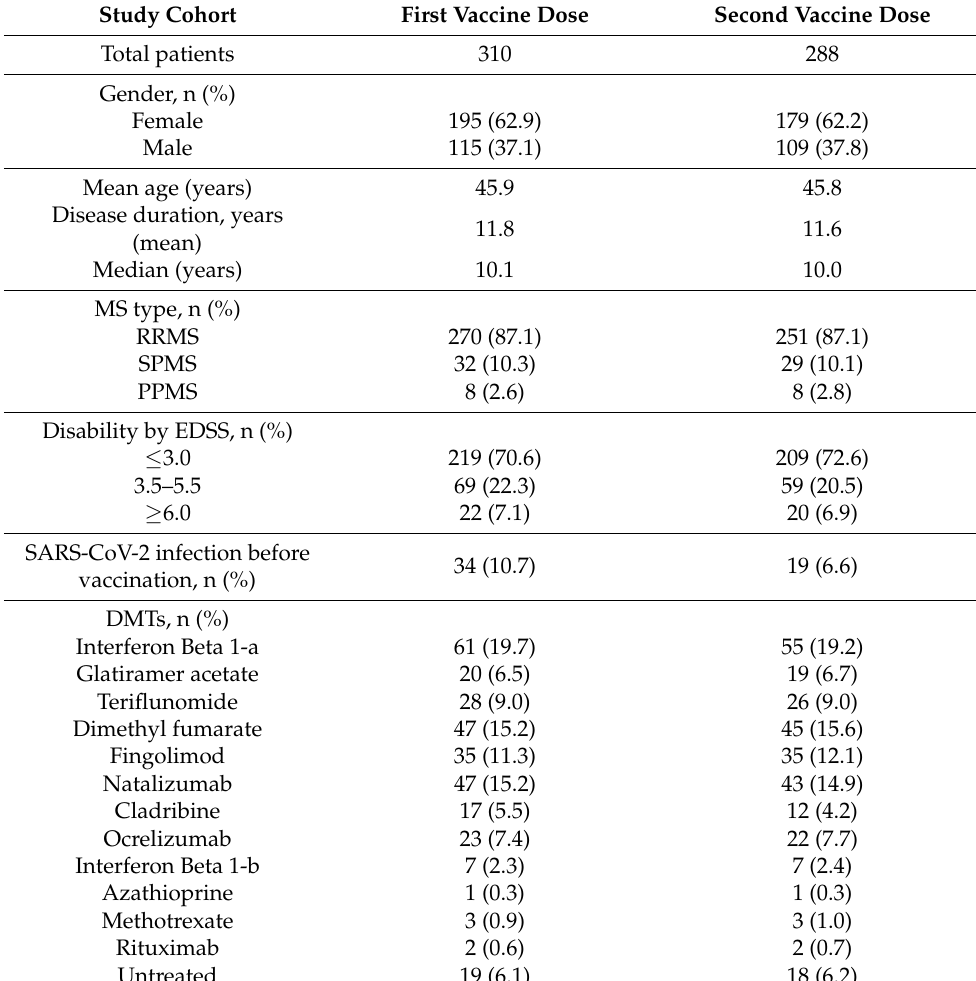
Table 1. Clinical and demographic variables of patients with multiple sclerosis who received COVID-19 vaccination.